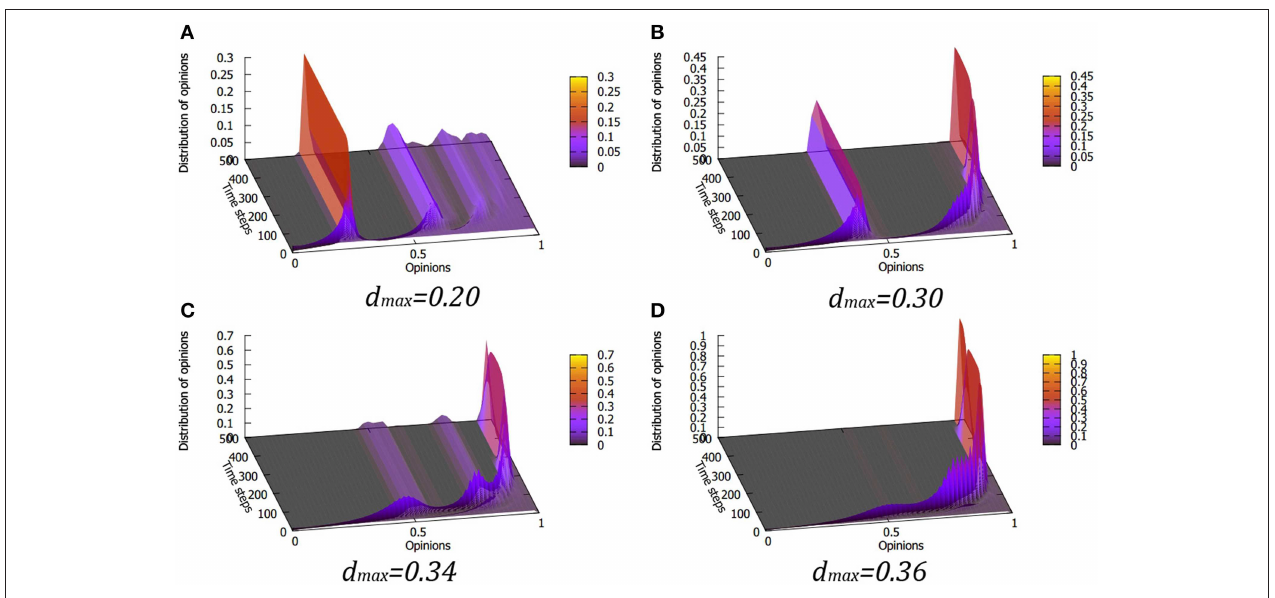
FIGURE 3 | Cumulative distribution of opinion evolution gathered from 200 simulation runs at various values of the maximum tolerance d max for the quadratic form of the Equation (5), i.e., L = 2 . As in the linear case, for small values of d max we observe stable maxima of opinions with decreasing separation as opinion increases (A) .